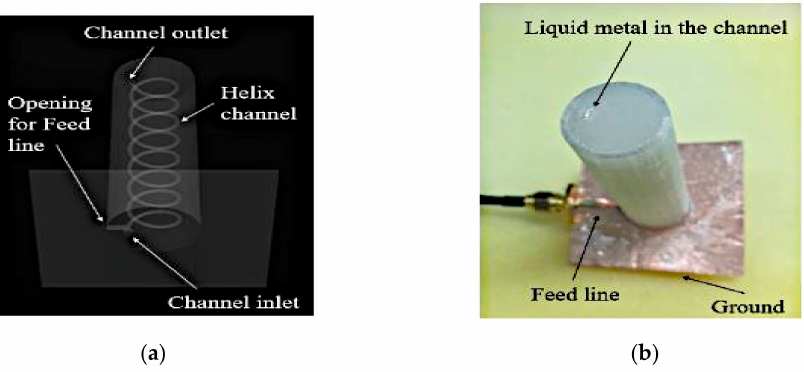
Figure 24. Fabricated prototype. ( a ) Photograph of antenna. ( b ) Proposed antenna